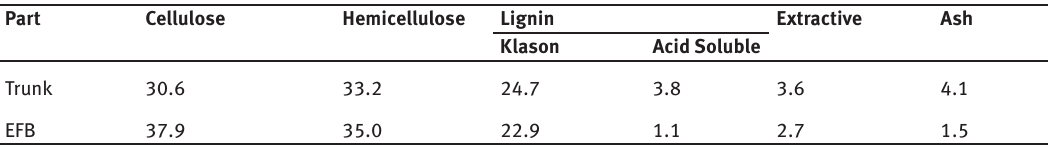
Table 1: The oil palm fiber’s composition (wt.%) [20]. Part Cellulose Hemicellulose